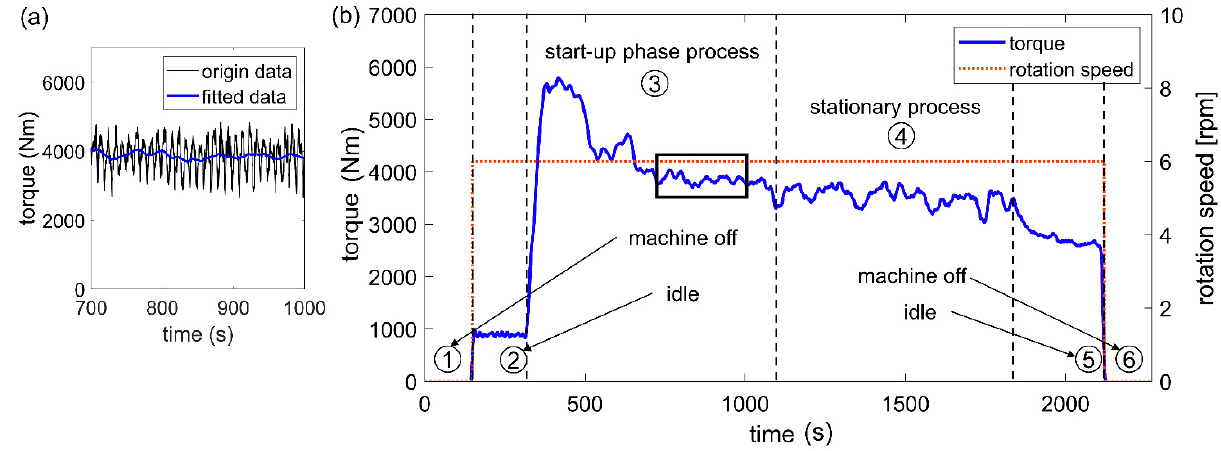
Figure 3. Change in speed and torque in the different process stages of the recycling process of EN-AW-6060 chips with a round 5 mm die and a rotational speed of 6 rpm. ( a ) Determination of an equalization curve for the original data. ( b ) Visualization of the change in torque over the speed.